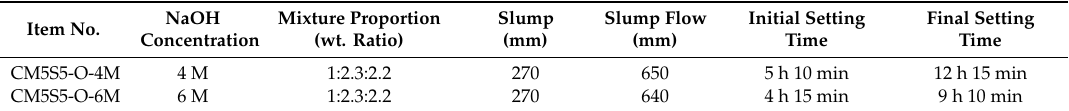
E ff ect of the NaOH molar concentration on the fresh properties of marble-based geopolymer concrete.